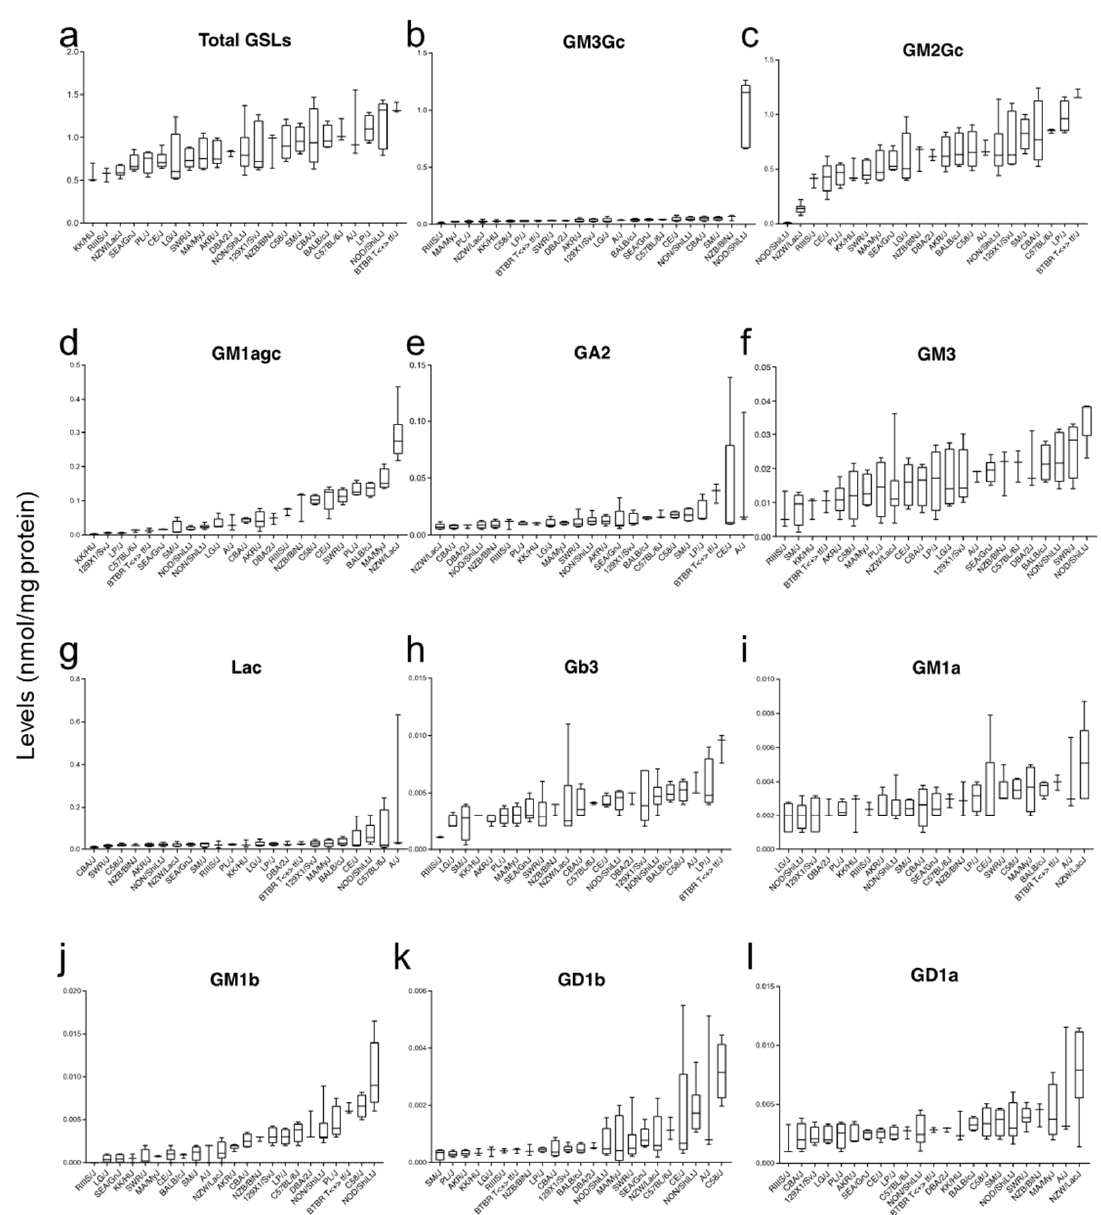
Figure 3. Variation of glycosphingolipids (GSLs) levels in liver of mouse inbred strains. Distribution of glycosphingolipids levels expressed as nmol/mg protein; ( a ) total GSLs (GM3-Gc + GM2-Gc + GM1agc + GA2 + GM3 + LacCer + Gb3 + GM1a + GM1b + GD1b + GD1a) levels. ( b ) GM3-Gc. ( c ) GM2-Gc. ( d ) GM1agc. ( e ) GA2. ( f ) GM3. ( g ) LacCer (Lac). ( h ) Gb3. ( i ) GM1a. ( j ) GM1b. ( k ) GD1b. ( l ) GD1a, in the liver of 23 mouse inbred strains. Values are presented as median (n = 3–5 per